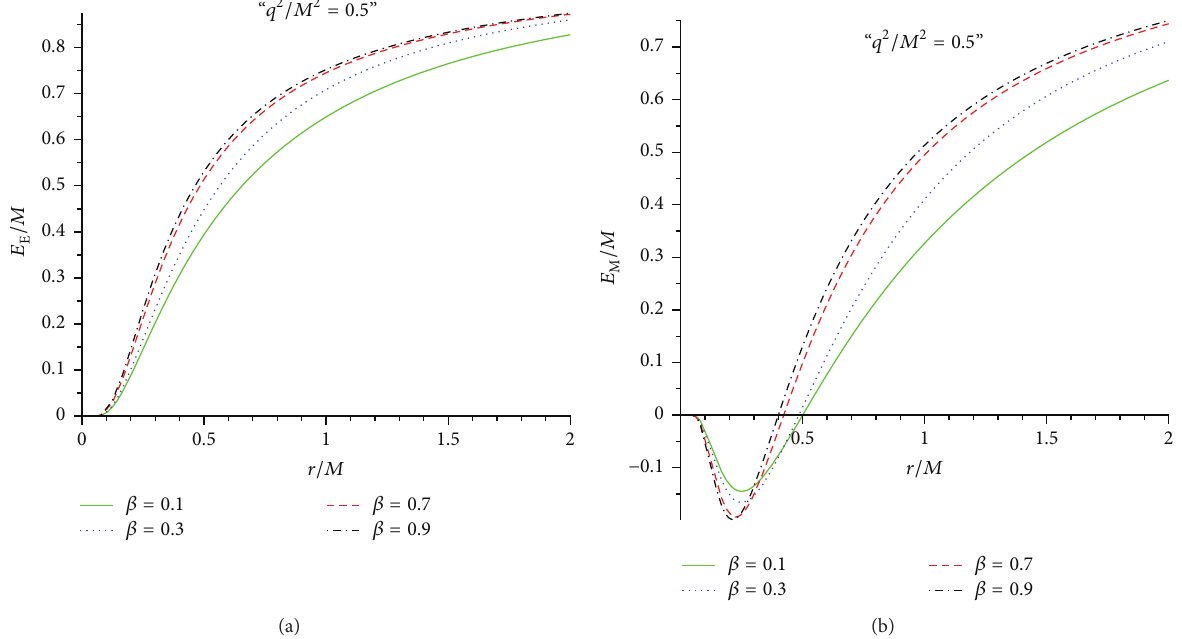
Figure 3: Energy distribution computed by the Einstein prescription (a) and the Møller prescription (b) near the origin for different values of 𝛽 and (𝑞/𝑀) 2 = 0.5